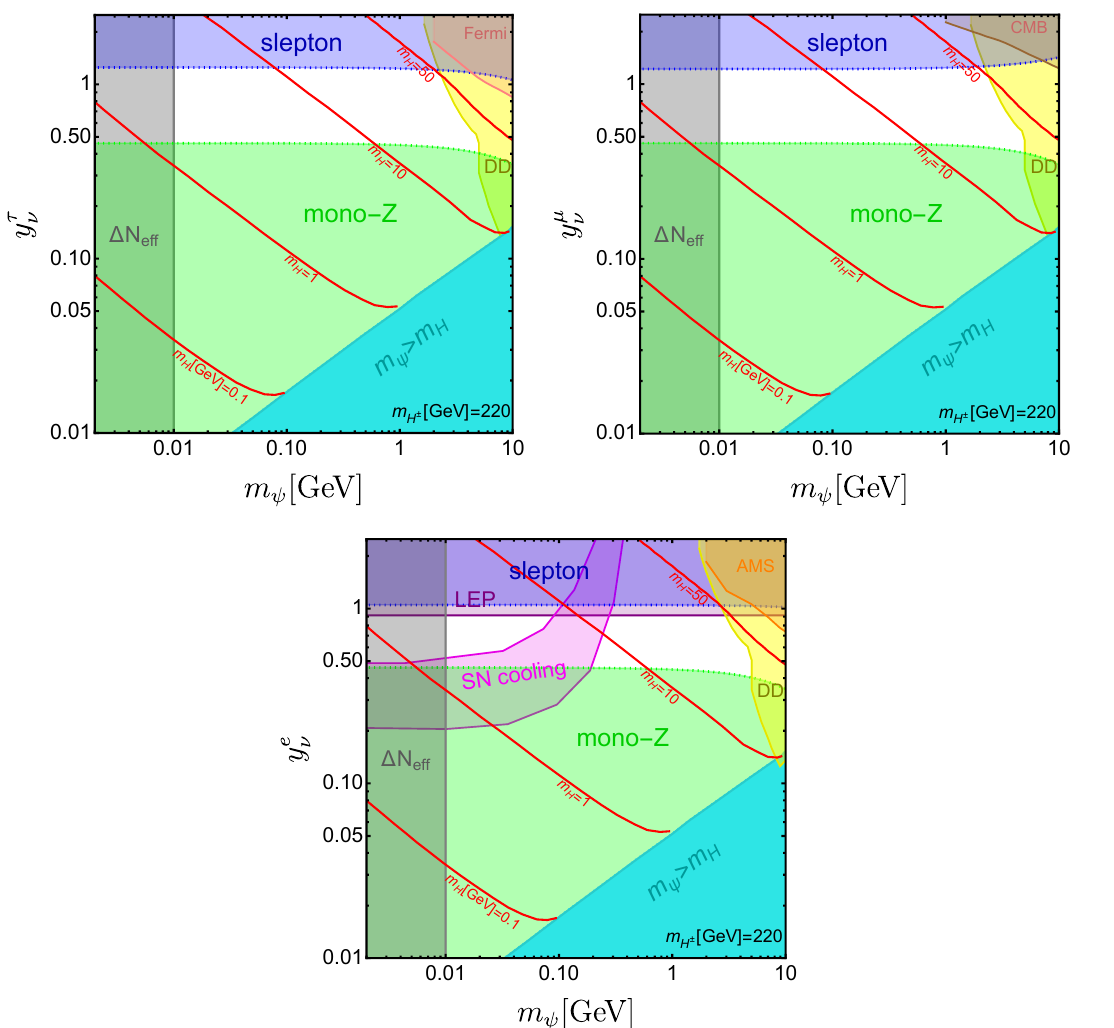
) plane with m = H ± ν